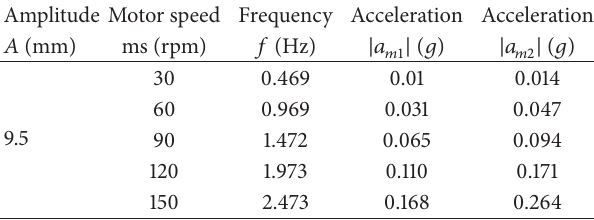
Table 2: Vibration parameters under five motor